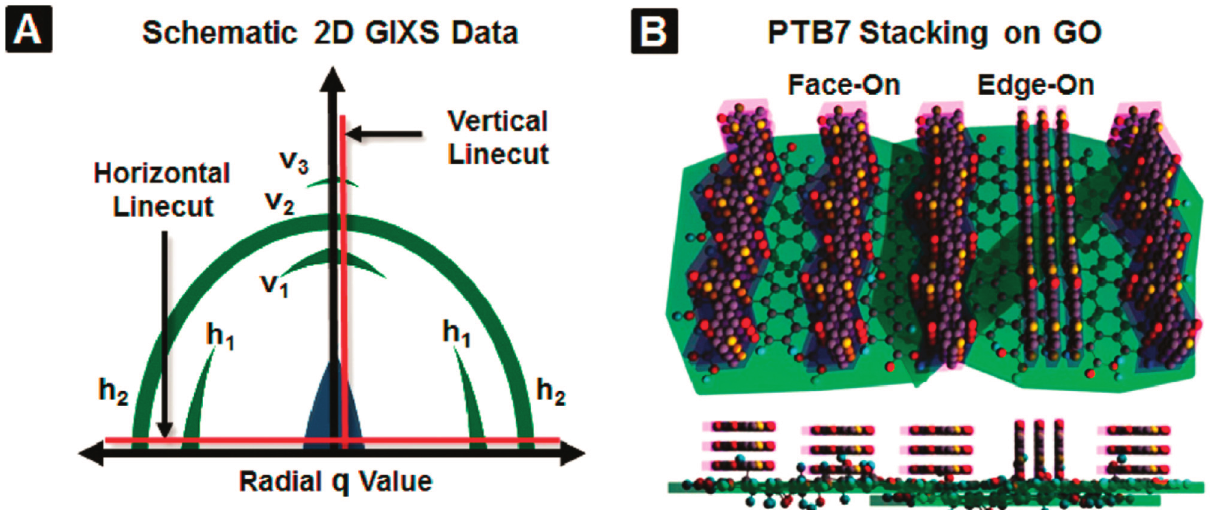
Figure 12. Grazing incidence X-ray scattering (GIXS) characterization of the microstructure of PSC active layer. ( A ) Schematic of raw 2D GIXS data and processing procedure for comparing signal intensities from multiple substrates, irradiated for equal times (see Supporting Information for complete 2D intensity maps); ( B ) Structural model from GIXS data showing preferential face-on PTB7 π -stacking on ITO/GO substrates. Reprinted with permission [92]. Copyright 2011 American Chemical